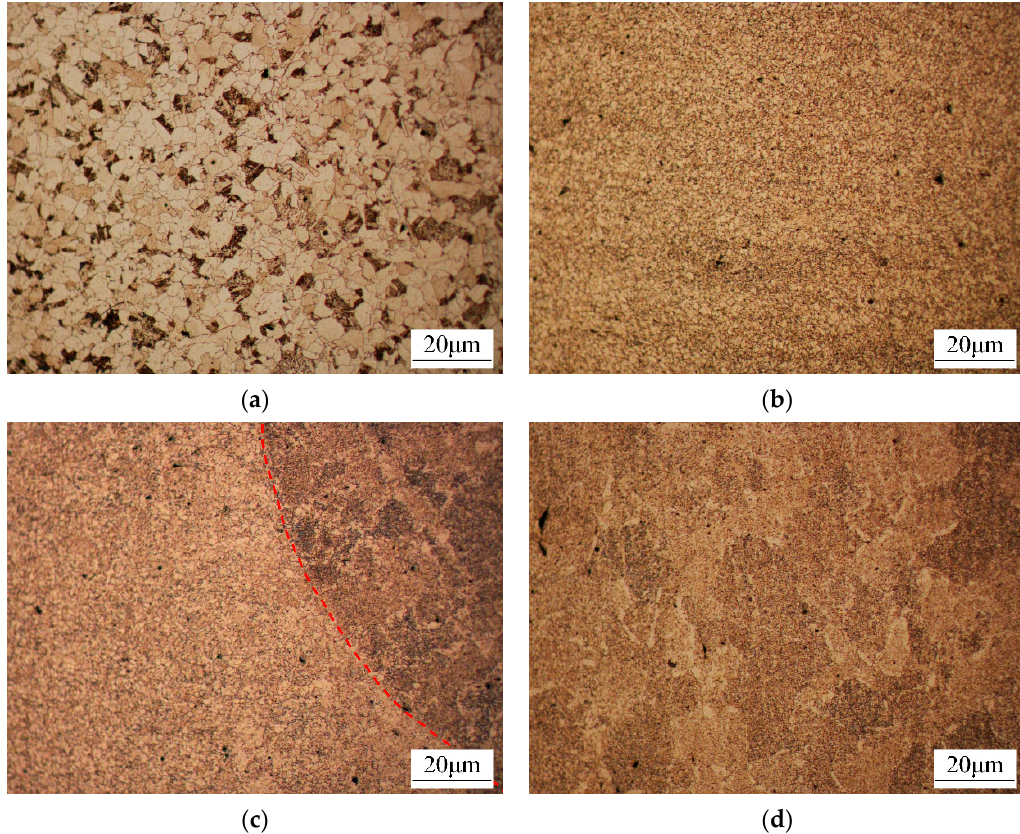
Figure 16. Microstructures of the 12Cr1MoV welded joint after tempering heat treatment. ( a ) Base metal, ( b ) heat-affected